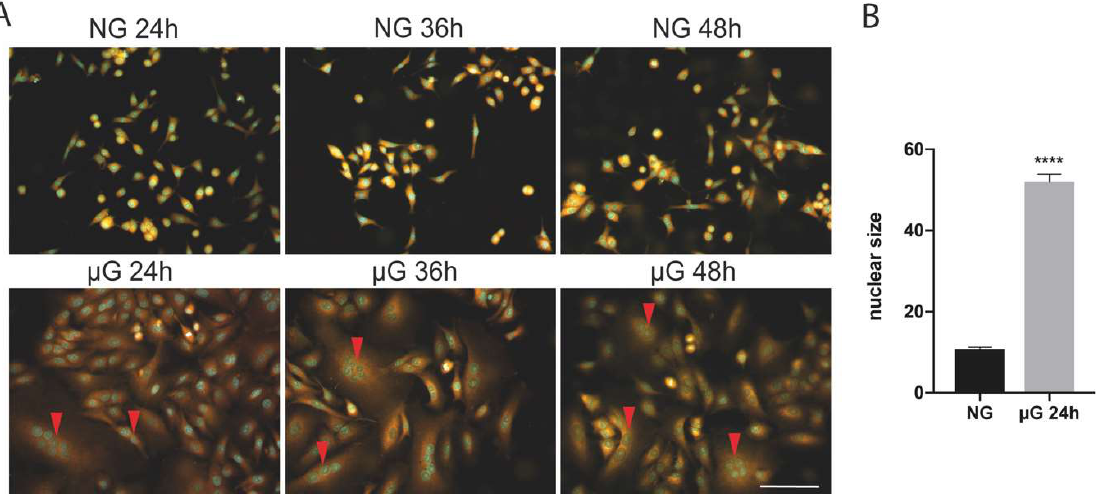
Figure 1. ( A ) Microgravity exposure of A549 cells is accompanied by the generation of polynucleated cells at 24 and 36 h. Multinucleated cells were observed during the various exposure times at high frequency (10–15% of the total). Scale bar: 100 µm. ( B ) Histogram showing the nuclear size (mean+/−SEM) in normal gravity (NG) versus 24 µG exposed cells ( n = 100 cells, **** p < 0.0001, T Student’s test). Table 1. Time course fluctuations in population doubling (PD) and cell cycle phases of A549 cells in NG and µG.